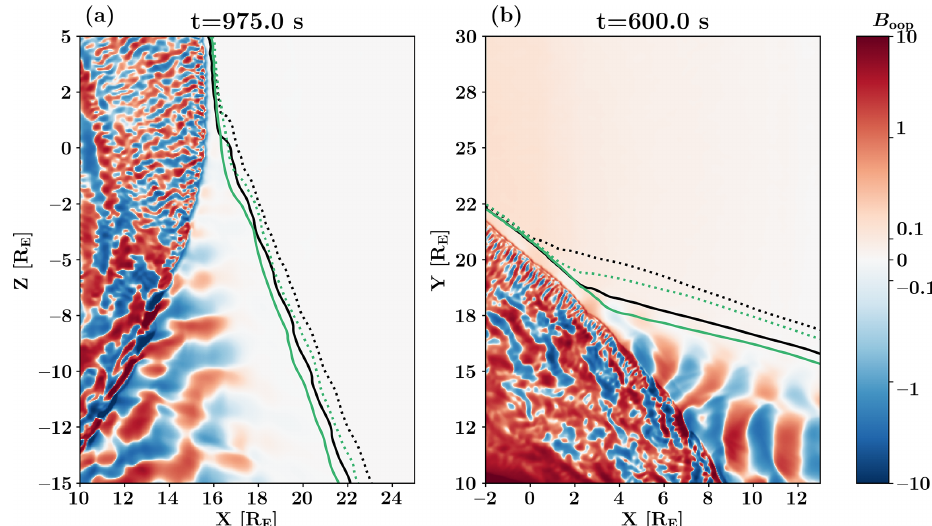
Figure 5. An enlarged view of the foreshock edge, with the magnetic field out-of-plane component B oop indicating the ULF foreshock extent. Contours indicate suprathermal ion densities, as in Fig. 2a, but averaged over 2min. (a) The meridional plane 45 ◦ IMF simulation used in the majority of this paper. (b) An equatorial plane 5 ◦ IMF run for comparison. The IMF orientation appears to affect the suprathermal ion density gradient at the foreshock